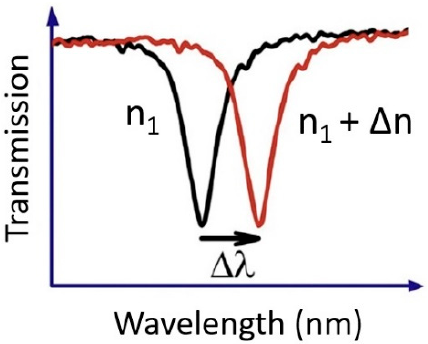
Figure 1. Resonance wavelength shift due to change in the refractive index. Reprinted with permission from [89]. Copyright © Elsevier (2012).